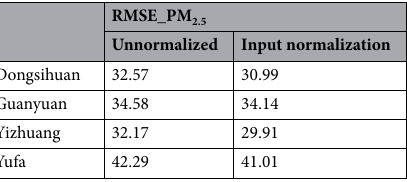
Table 8. Comparison of prediction results of three pollutant parameters in LightGBM model at a single site.